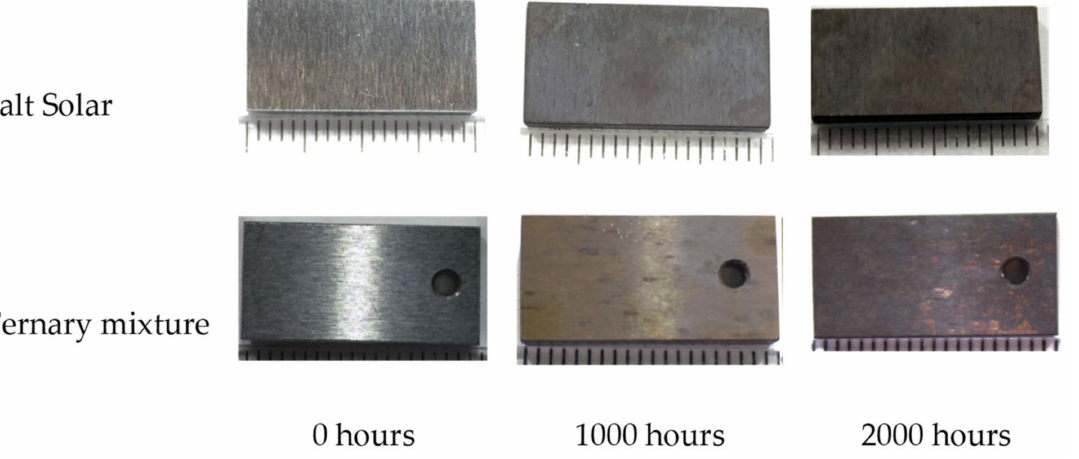
Figure 8. Visual aspect of the coupons at different stages of the test. However, any evident degradation signal was identified visually with the current state-of-the-art fluid. In Solar Salt, after 2000 h, there were preferential oxide growth areas on the sample, surely caused by grinding defects and the flow direction (see Figure 9). In the same figure, The SEM-EDX measurements on the surface revealed an atomic percentage of Fe, Cr and O, an indication of Fe-Cr-O spinels. Meanwhile, according to the specific chemical analyses #1 and #2 of the sample, a preferential combination of Fe-O was formed. Although very poor, Na presence leads one to think of a possible intermediate Na 2 O formation due to the oxyanion (O − 2 ) affinity with this element [54].